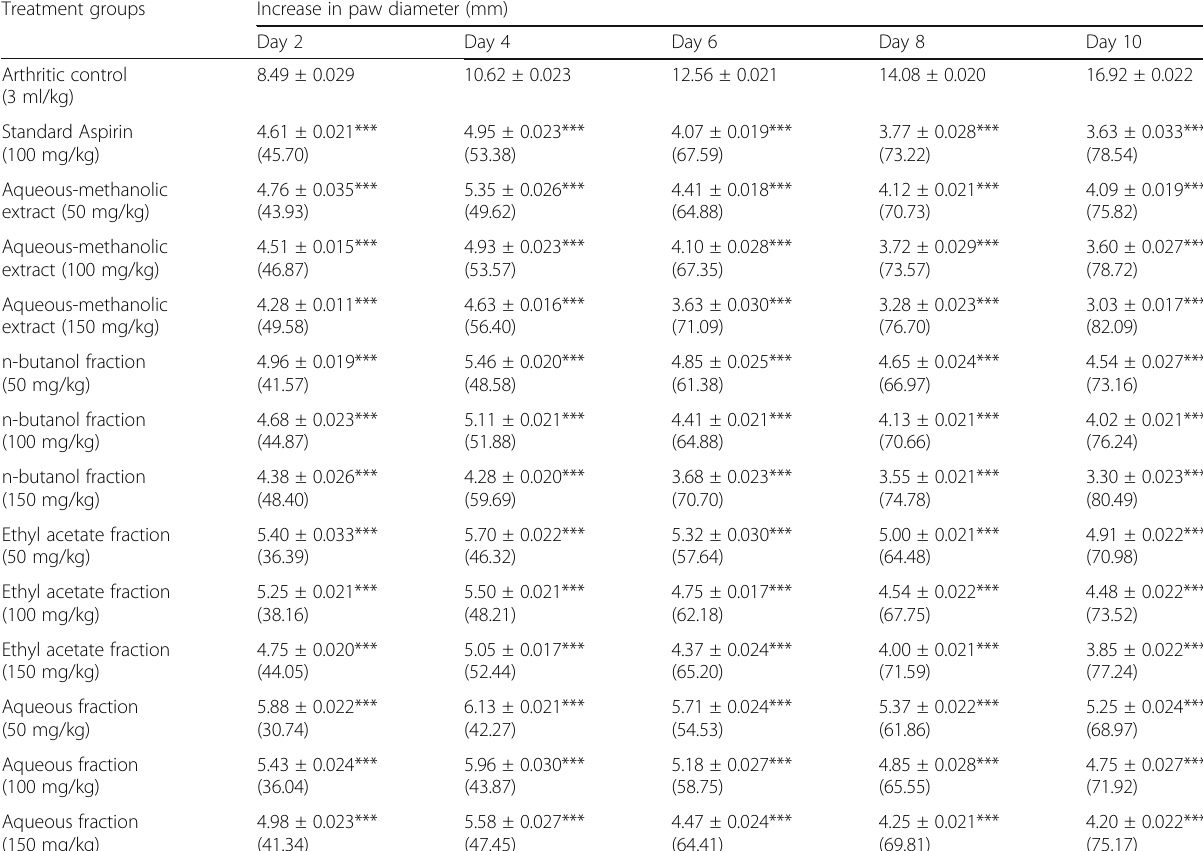
Table 2 Effect of B.orthobotrys on formaldehyde induced arthritis in rats ( n = 5, Mean ± SEM)